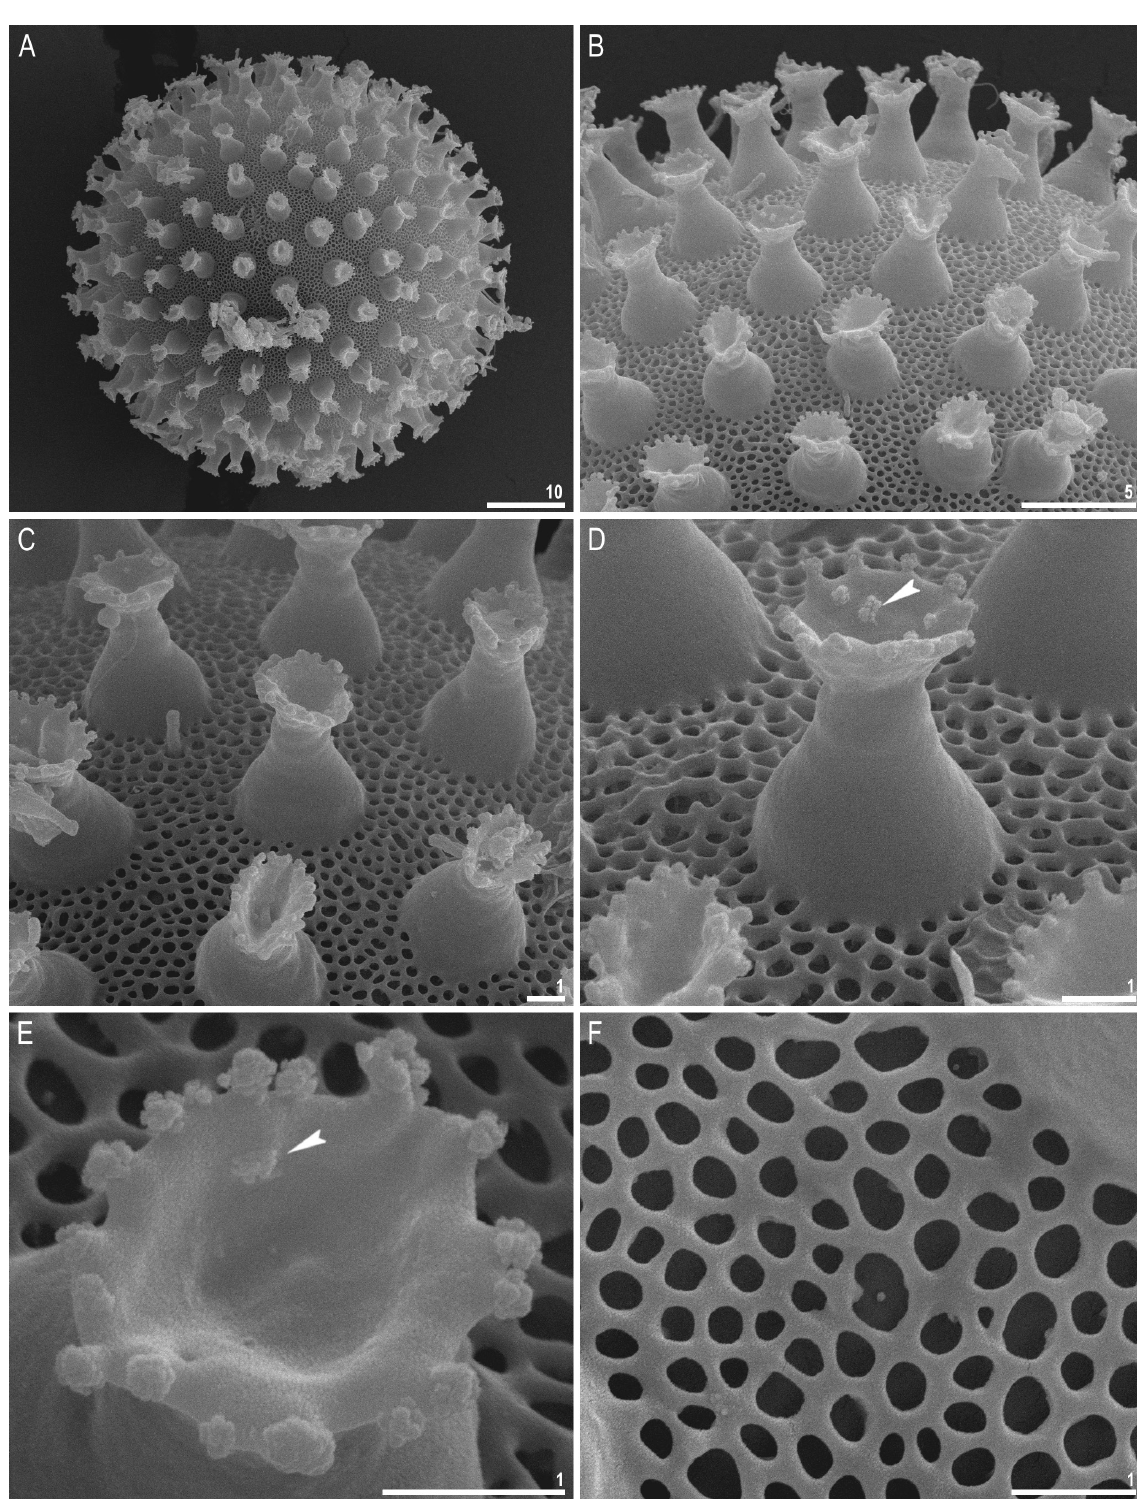
Fig. 15. Macrobiotus kamilae sp. nov., egg chorion morphology seen in SEM (IZiBB). A . Entire egg. B–C . Magnifications of the egg surface. D . Egg process morphology. E . Terminal disc. F . Details of the reticulation between egg processes. Arrowheads indicate scattered granules on the terminal disc surface. Scale bars in